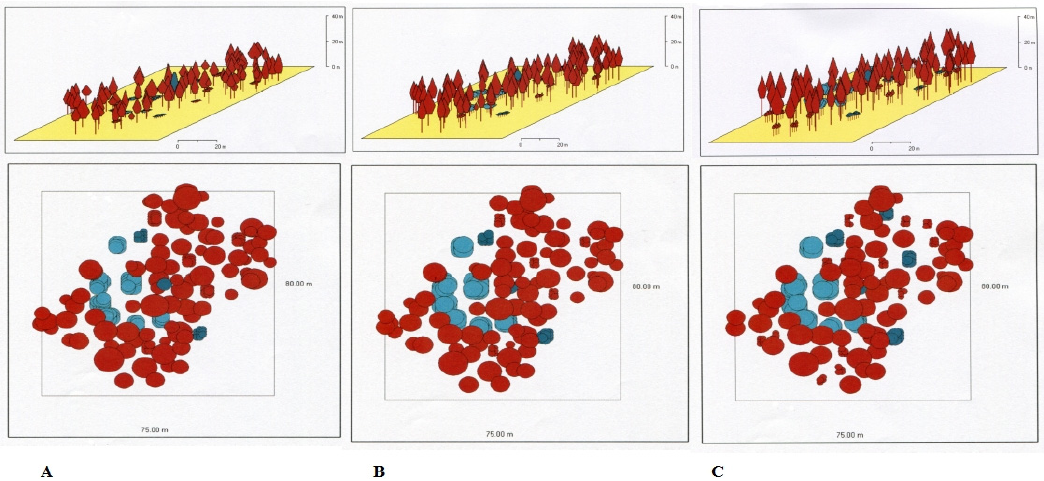
Figure 4. Growth simulation model for study site 2 (alochtonous Norway spruce forest) under a special management (i.e., underplanting) plan: status quo ( A ), and visualization of the future forest development for the period of 25 years ( B ) and 50 years ( C ). Red = Picea abies , blue = Sorbus aucuparia .